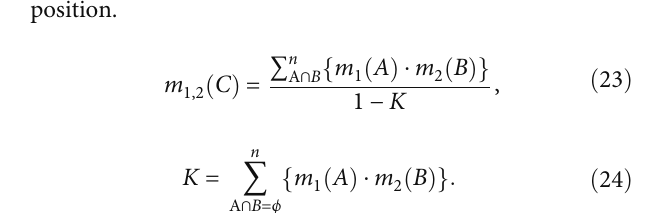
Figure 8: Information processing